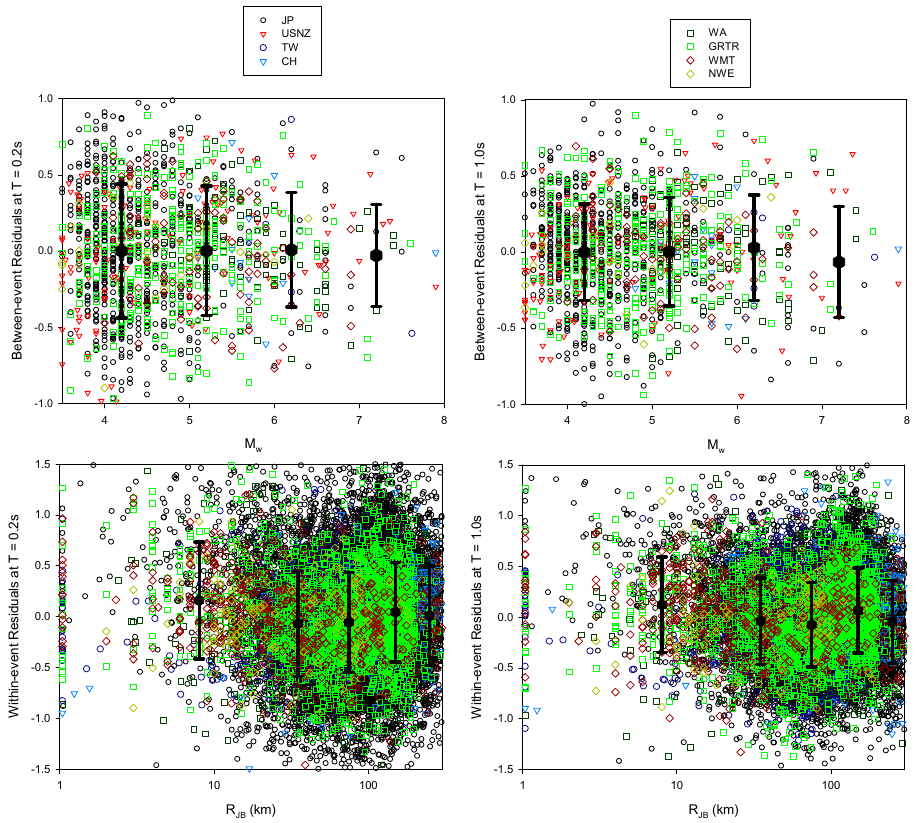
Figure 2. Between-event and within-event residual distributions of the reference rock motion predictive equations at T = 0.2 s ( left column ) and T = 1.0 s ( right column ). The same color-coding with Figure 1 is